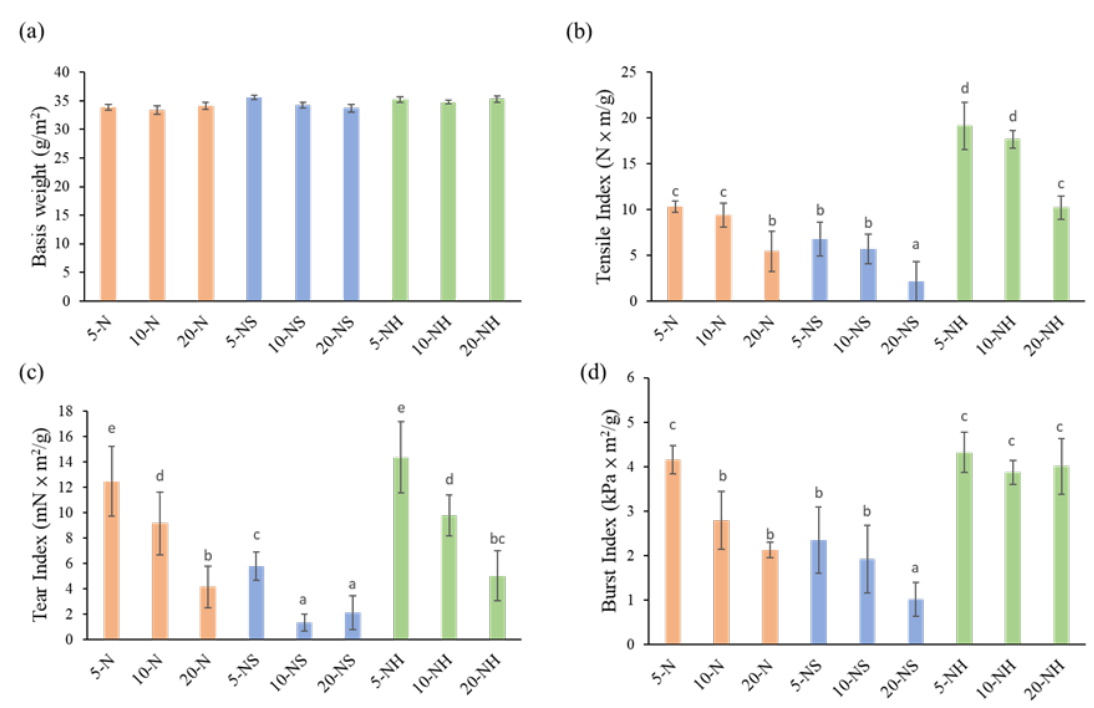
Figure 6. ( a ) Basic weights, ( b ) tensile index, ( c ) tear index and ( d ) burst index of Rhizoclonium pulp samples under different cooking treatments in handsheets. Letters indicate a significant difference within each experiment at p < 0.05 in comparison.